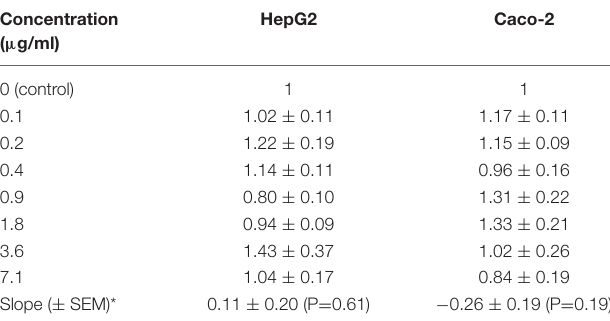
TABLE 3 | Intracellular reactive oxygen species (ROS) production (relative to control) in HepG2 and Caco-2 cells after exposure for 3h to nanoplastic from recycled PET food